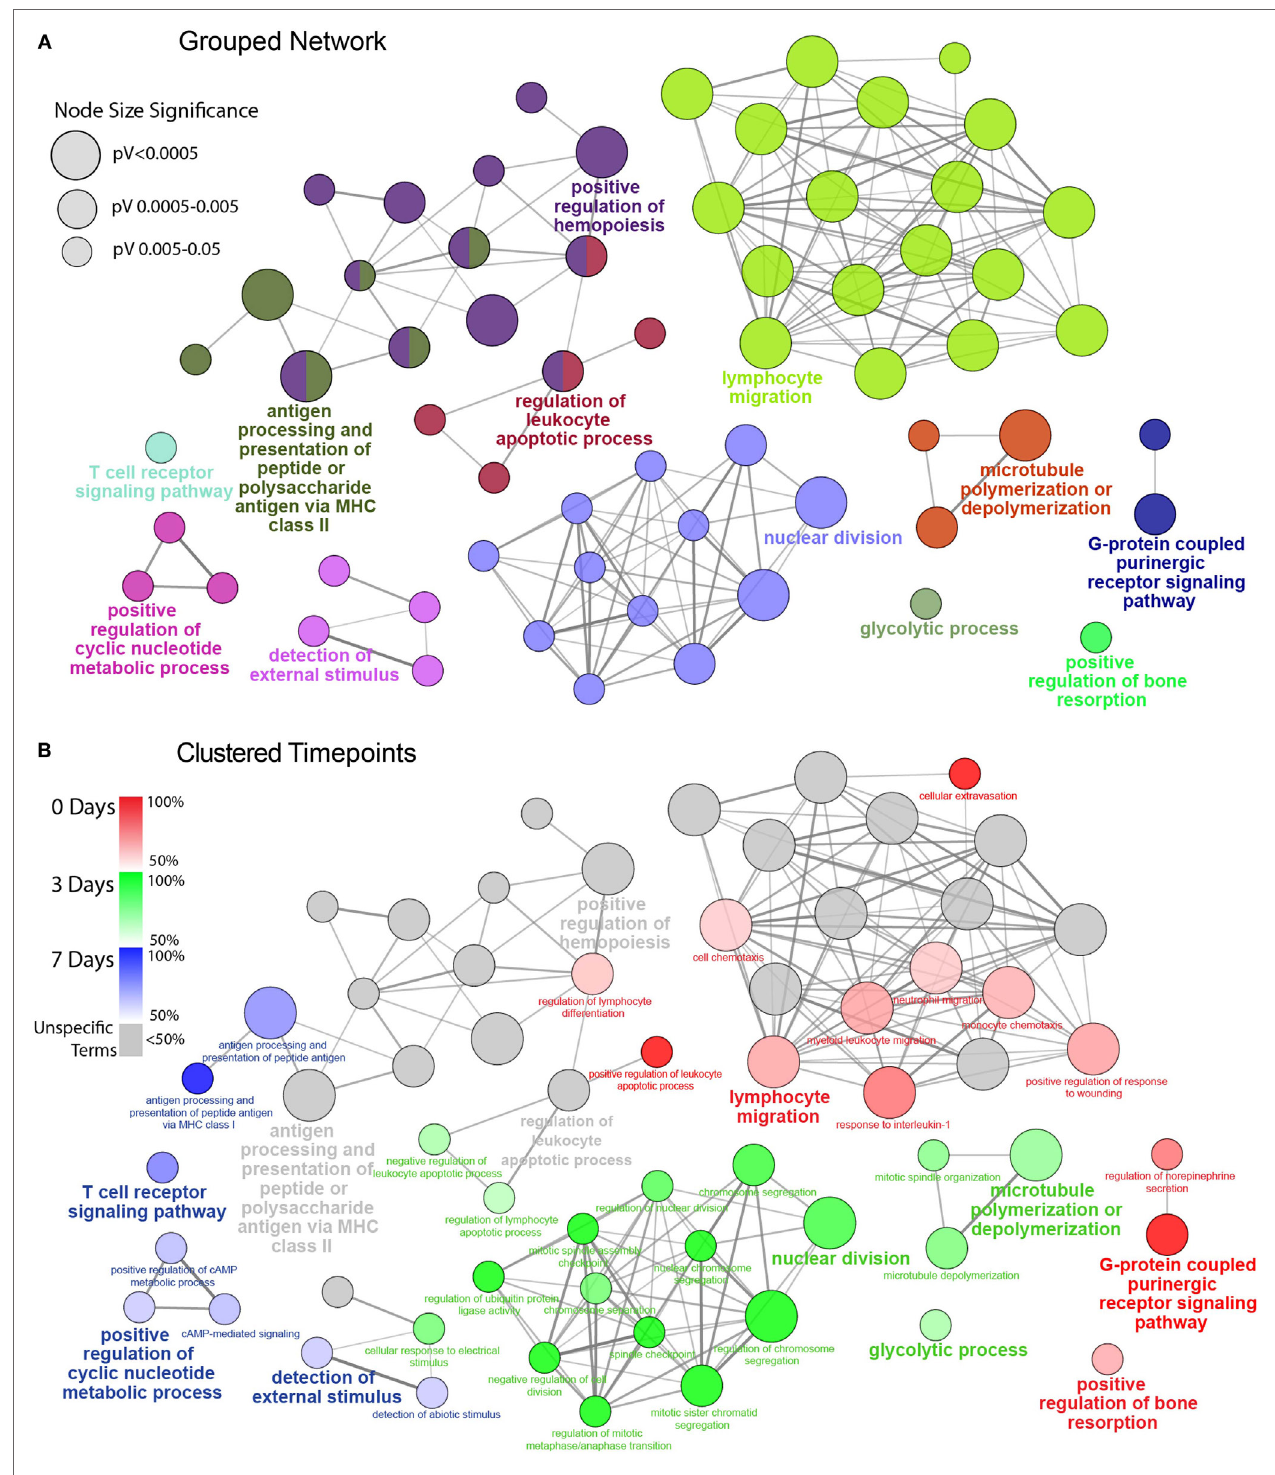
FigUre 3 | Functionally grouped network analysis of enriched GO terms for CD45 Population over the timecourse. (a) The top 100 DEGs from each timepoint were used to generate enriched GO terms for biological process, which were then integrated into a functionally grouped network. GO:BP terms are represented as nodes, while their size illustrates the significance of the term enrichment; the edges reflect the degree of connectivity and grouping between the terms. The leading term in each functional grouping is selected based on the highest significance (Bonferroni adj. P < 0.05). (B) The network is overlayed with the enrichment of the timepoints across the functional groupings; nodes in which more than 50% of the genes are attributed to a given timepoint are color-coded accordingly. BP, biological process; DEG, differentially expressed gene; GO, gene